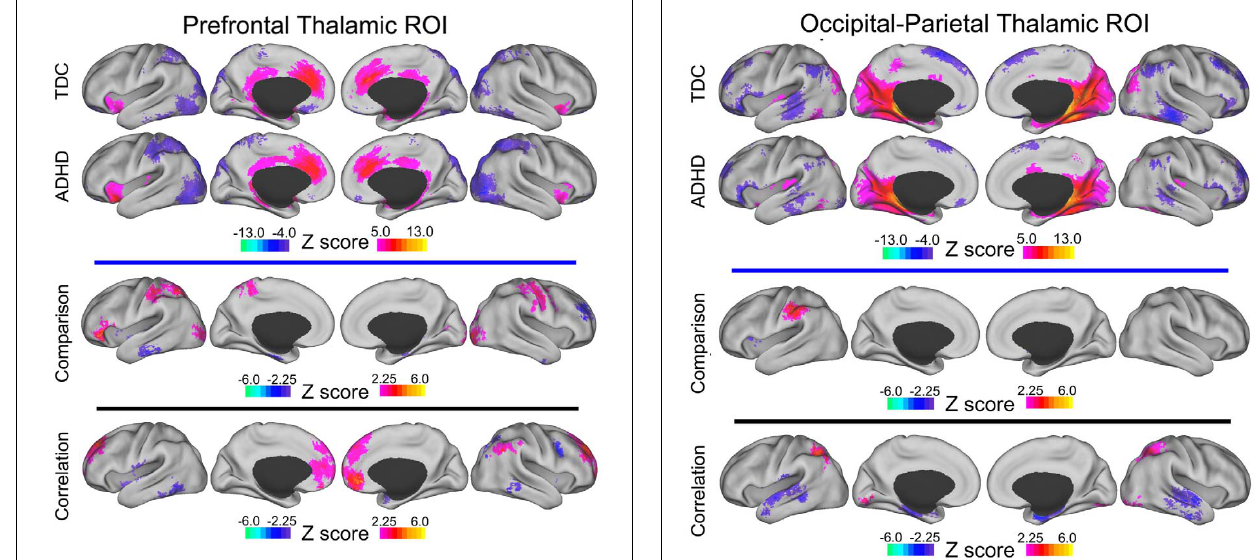
FIGUREA3 | Occipital–parietal thalamic voxelwise maps projected onto cortical surfaces. Each row displays the cortical surface for each voxelwise map generated from the occipital–parietal thalamic ROI: group maps forTDC, group maps for ADHD-C, maps from the comparative analysis (TDC vs. ADHD-C), and maps from the correlation analysis. Cortical surface projection was performed with the (PALS)-B12 atlas (Van Essen, 2005) and the software Caret (Van Essen et al.,